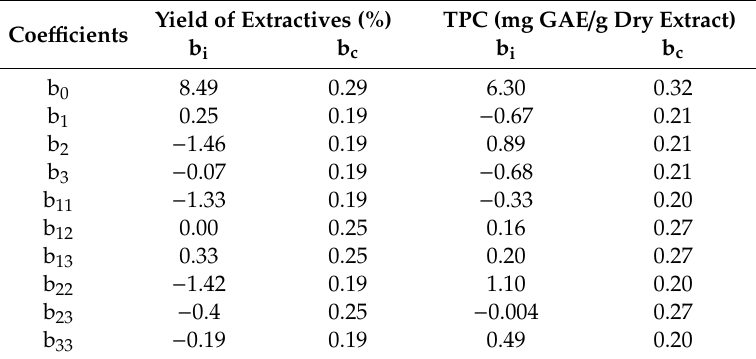
Table 4. Regression analysis for yield of extractives and total phenolics